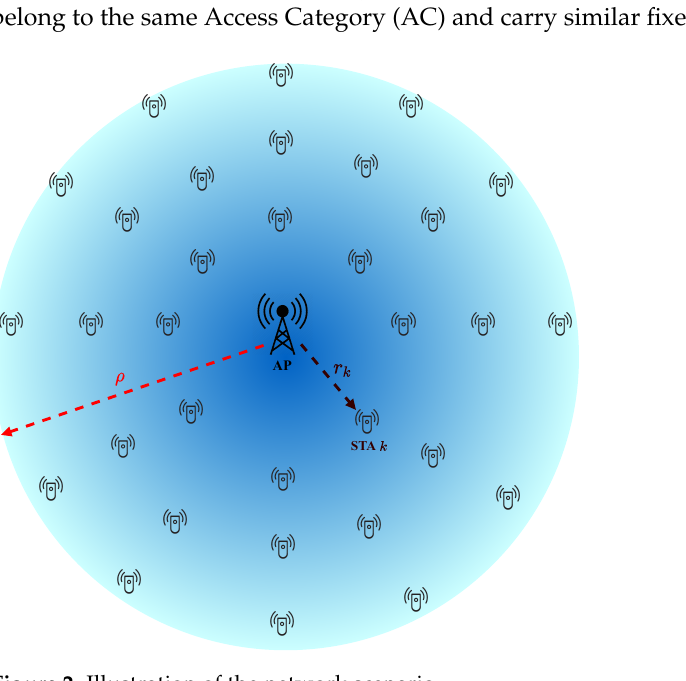
Figure 2. Illustration of the network